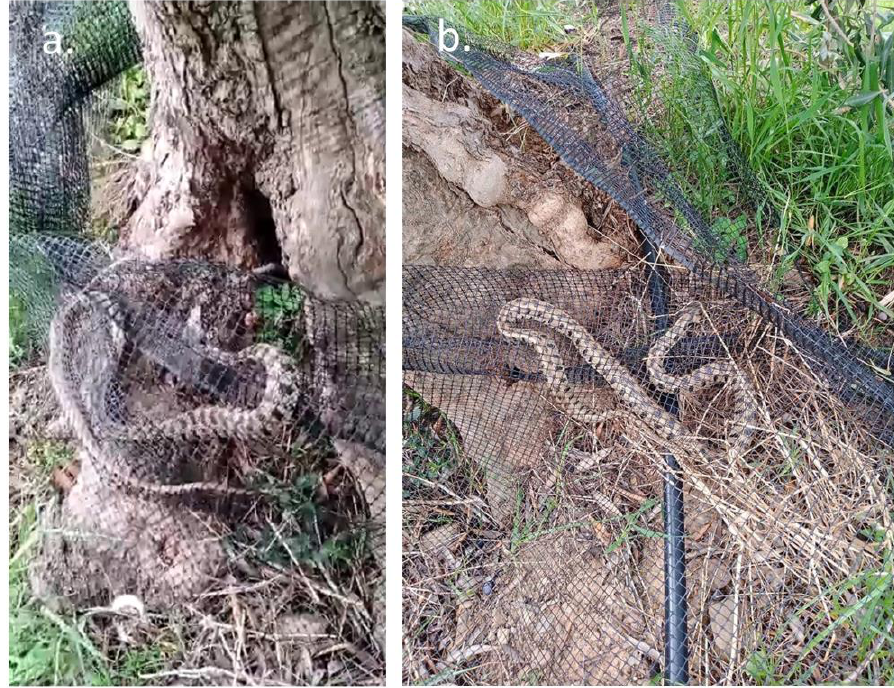
Figure 4. Photographic documentation, from the island of Lesvos, Greece, of a Grass snake ensnared within a plastic olive-harvesting net within a traditional olive grove: ( a ) the ensnared snake in proximity to an olive-tree cavity, and ( b ) the ensnared snake relocating from its initial position in an effort to extricate itself.